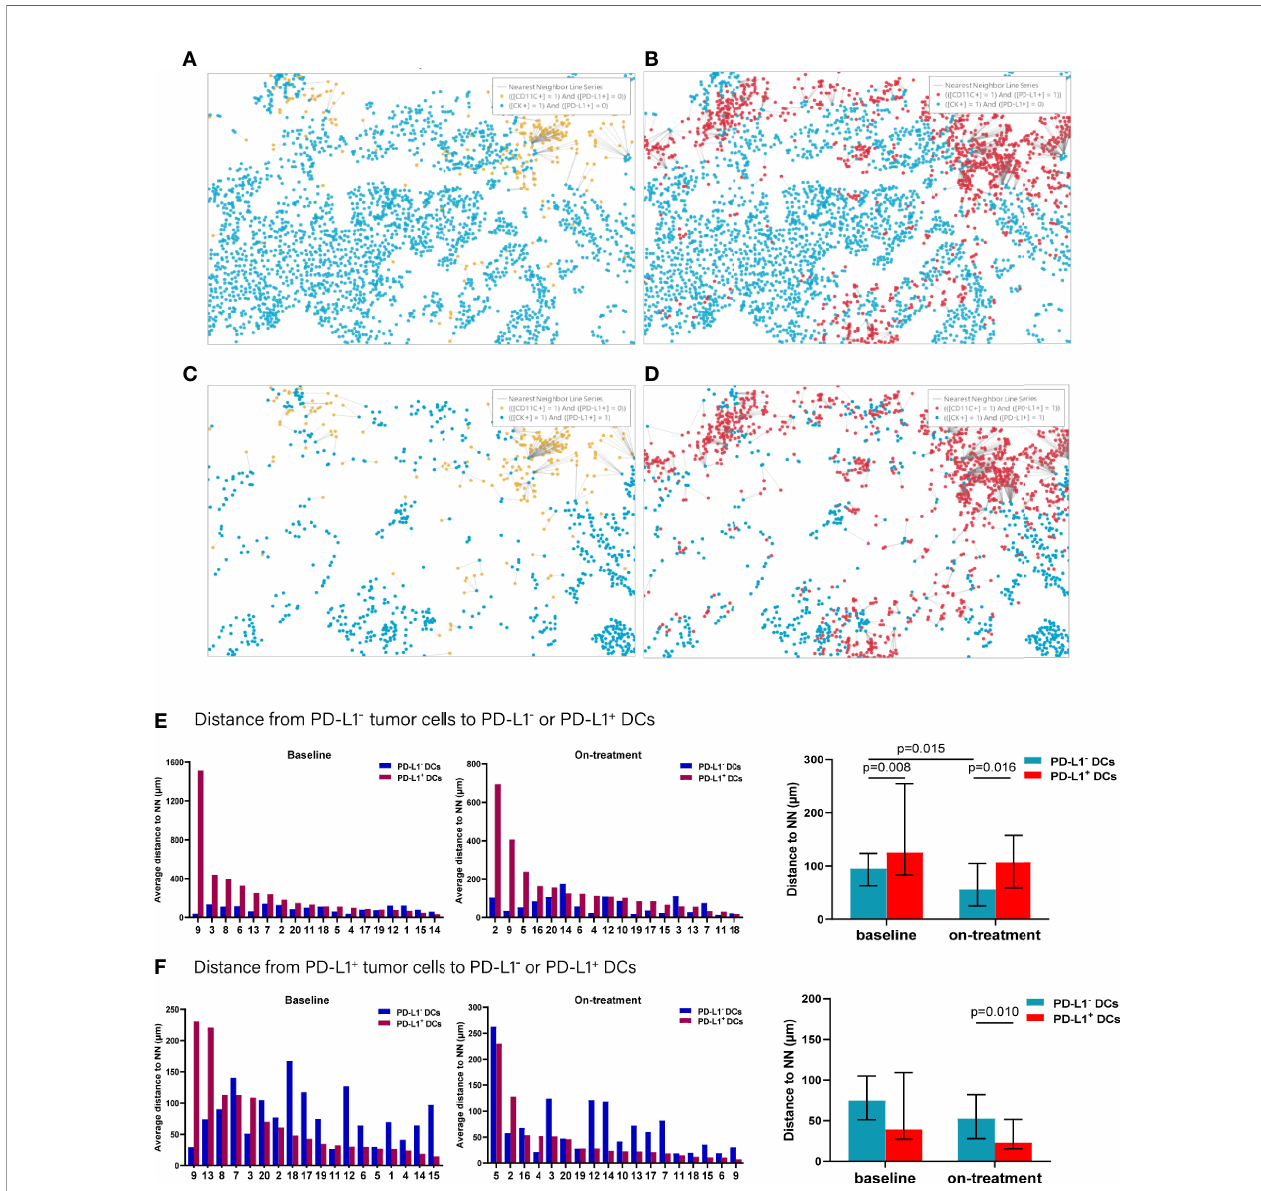
FIGURE 4 | Distance from PD-L1 - or PD-L1 + tumor cells to the nearest PD-L1 - or PD-L1 + dendritic cells. (A – D) Spatial analysis shown in Figure 3A . (A) Ray plot depicting the distance from each CK + PD-L1 - tumor cell to the nearest PD-L - dendritic cell. (B) Ray plot depicting the distance from each CK + PD-L1 - tumor cell to the nearest PD-L1 - dendritic cells. (C) Ray plot depicting the distance from each CK + PD-L1 + tumor cell to the nearest PD-L - dendritic cell. (D) Ray plot depicting the distance from each CK + PD-L1 + tumor cell to the nearest PD-L + dendritic cells. (E) Distances from PD-L1 - tumor cells to the nearest PD-L1 - or PD-L1 + dendritic cells at baseline and during treatment. (F) Distances from PD-L1 + tumor cells to the nearest PD-L1 - or PD-L1 + dendritic cells at baseline and during treatment. The tumors are ordered by the percentage of PD-L1 + dendritic cells, from highest to lowest. On-treatment, after 40 Gy radiation. p ≤ 0.05, statistically signi fi cant.